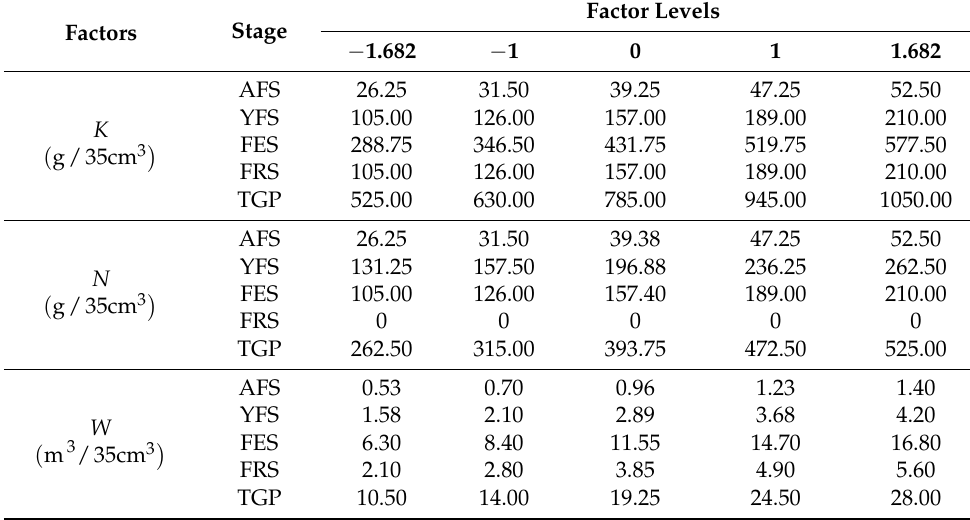
Table 2. Irrigation and fertilization